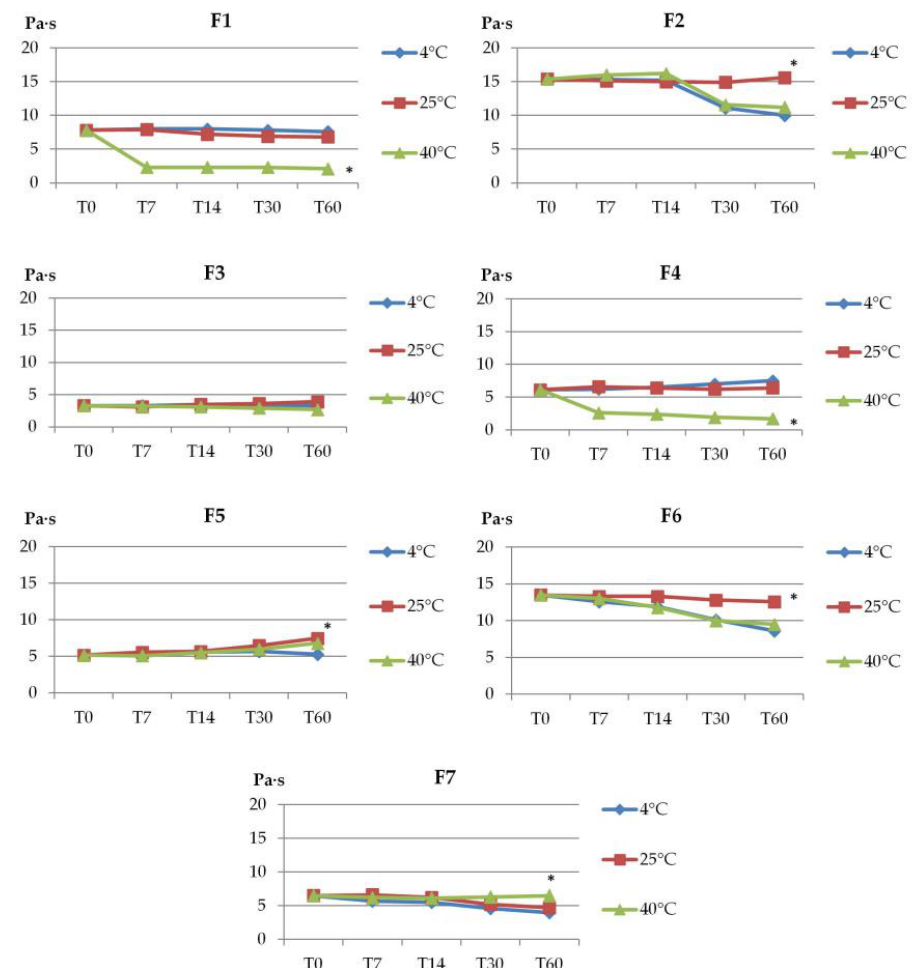
Figure 2. The viscosity of gel formulations during storage at different temperatures (4 ◦ C, 20 ◦ C, 40 ◦ C). Viscosity was measured at 25 ◦ C ± 1 ◦ C and values are expressed as mean ± SD, n = 3; * represents significant differences with p < 0.05; (T0—immediately after preparation, T7, T14, T30, and T60—after 7, 14, 30, and 60 days of storage).